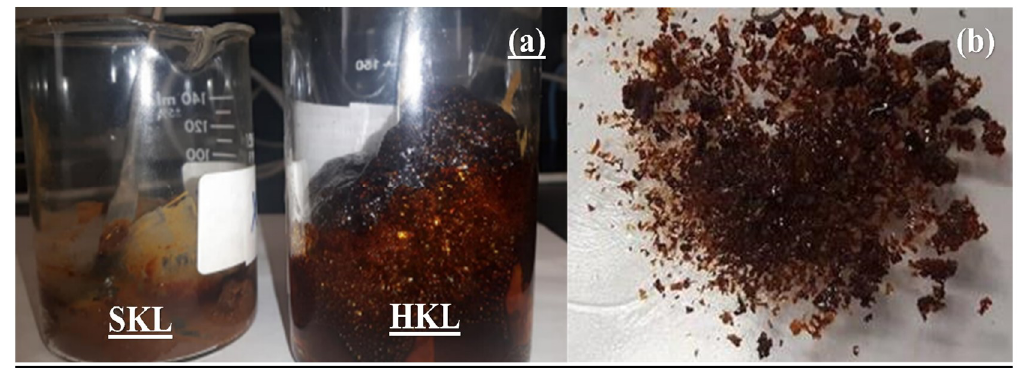
Figure 1. ( a ) SKL and HKL reaction mixtures during oxidative treatment with concentrated hydrogen peroxide and ( b ) depolymerized lignin sample after the treatment.